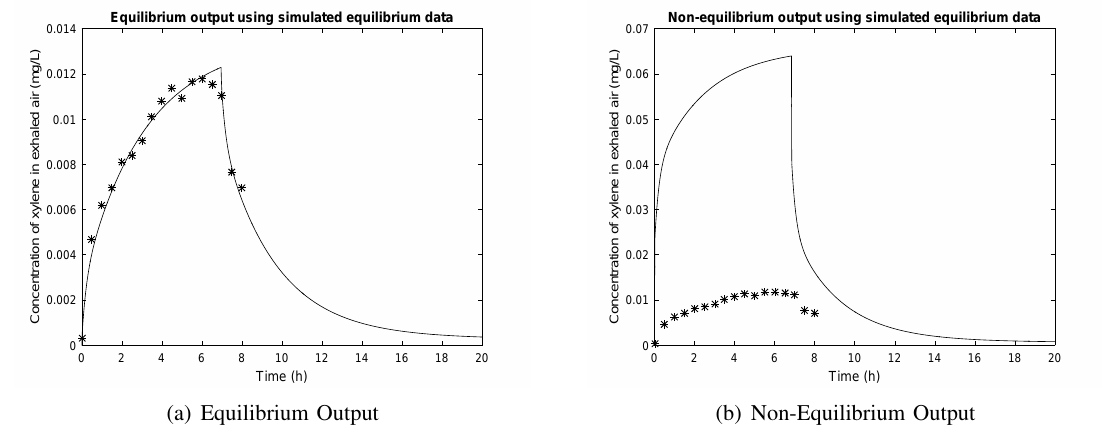
Fig. 6. Model output for the concentration of xylene in exhaled air after optimization over data simulated from the equilibrium model with noise level 0.001 and V xyl maxc = 6 . Figure (a) contains equilibrium model output and Figure (b) contains non- equilibrium model output.